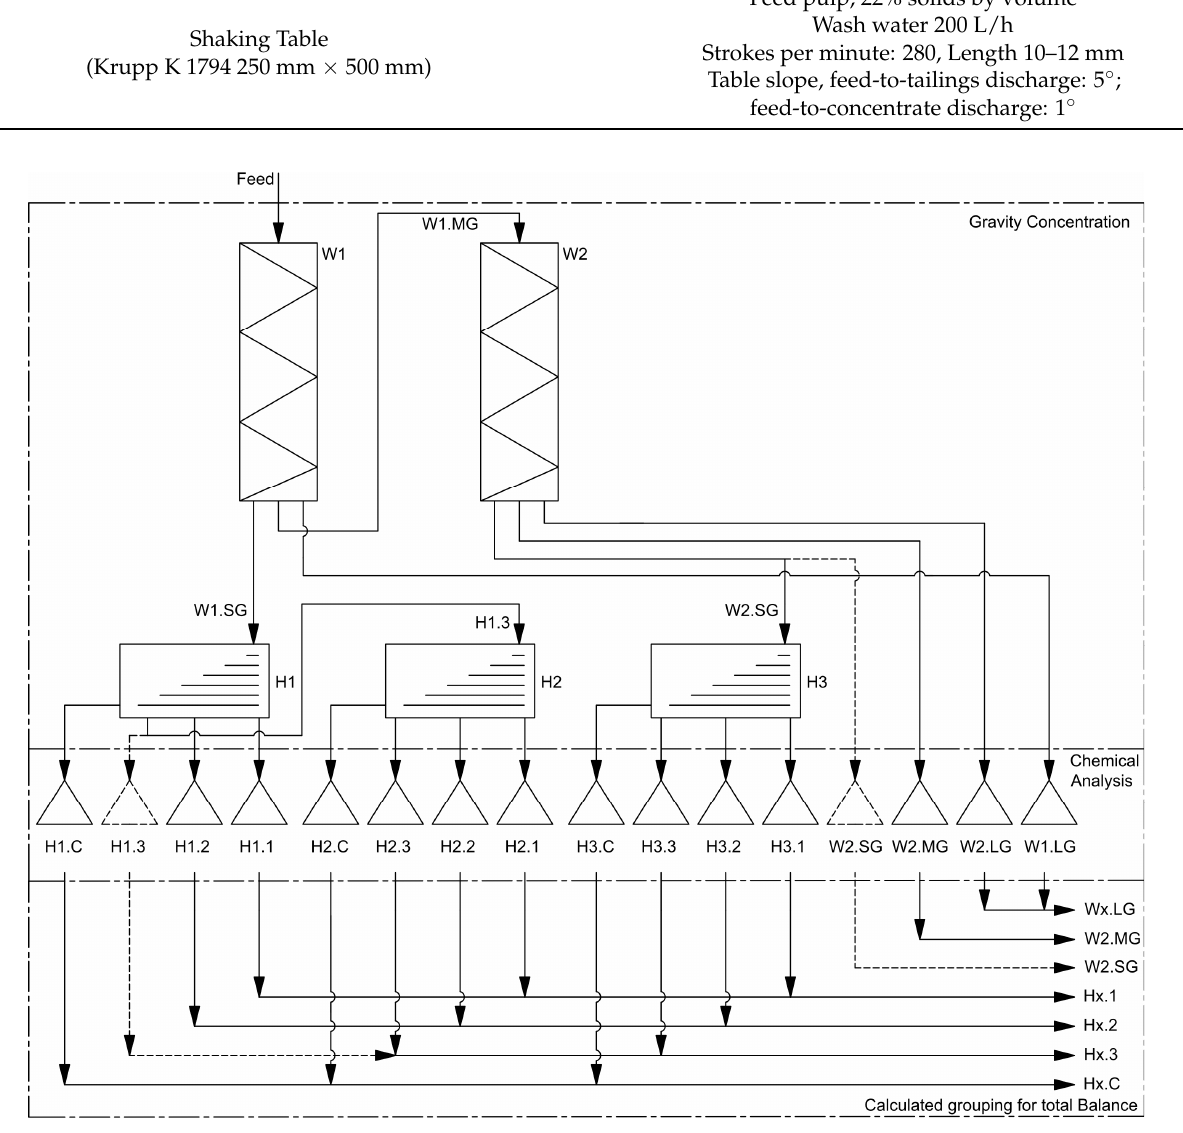
Figure 6. Flowchart of gravity concentration trials. Not all samples were fed to the second (H2) or third (H3) shaking tables (dashed lines) if the mass was insufficient for the following chemical